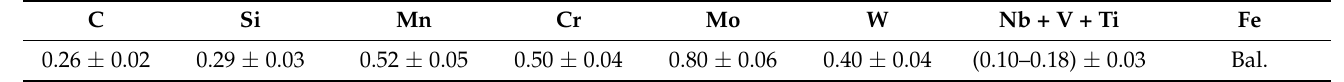
Table 1. Chemical composition of the 0.5Cr0.4W steel with errors